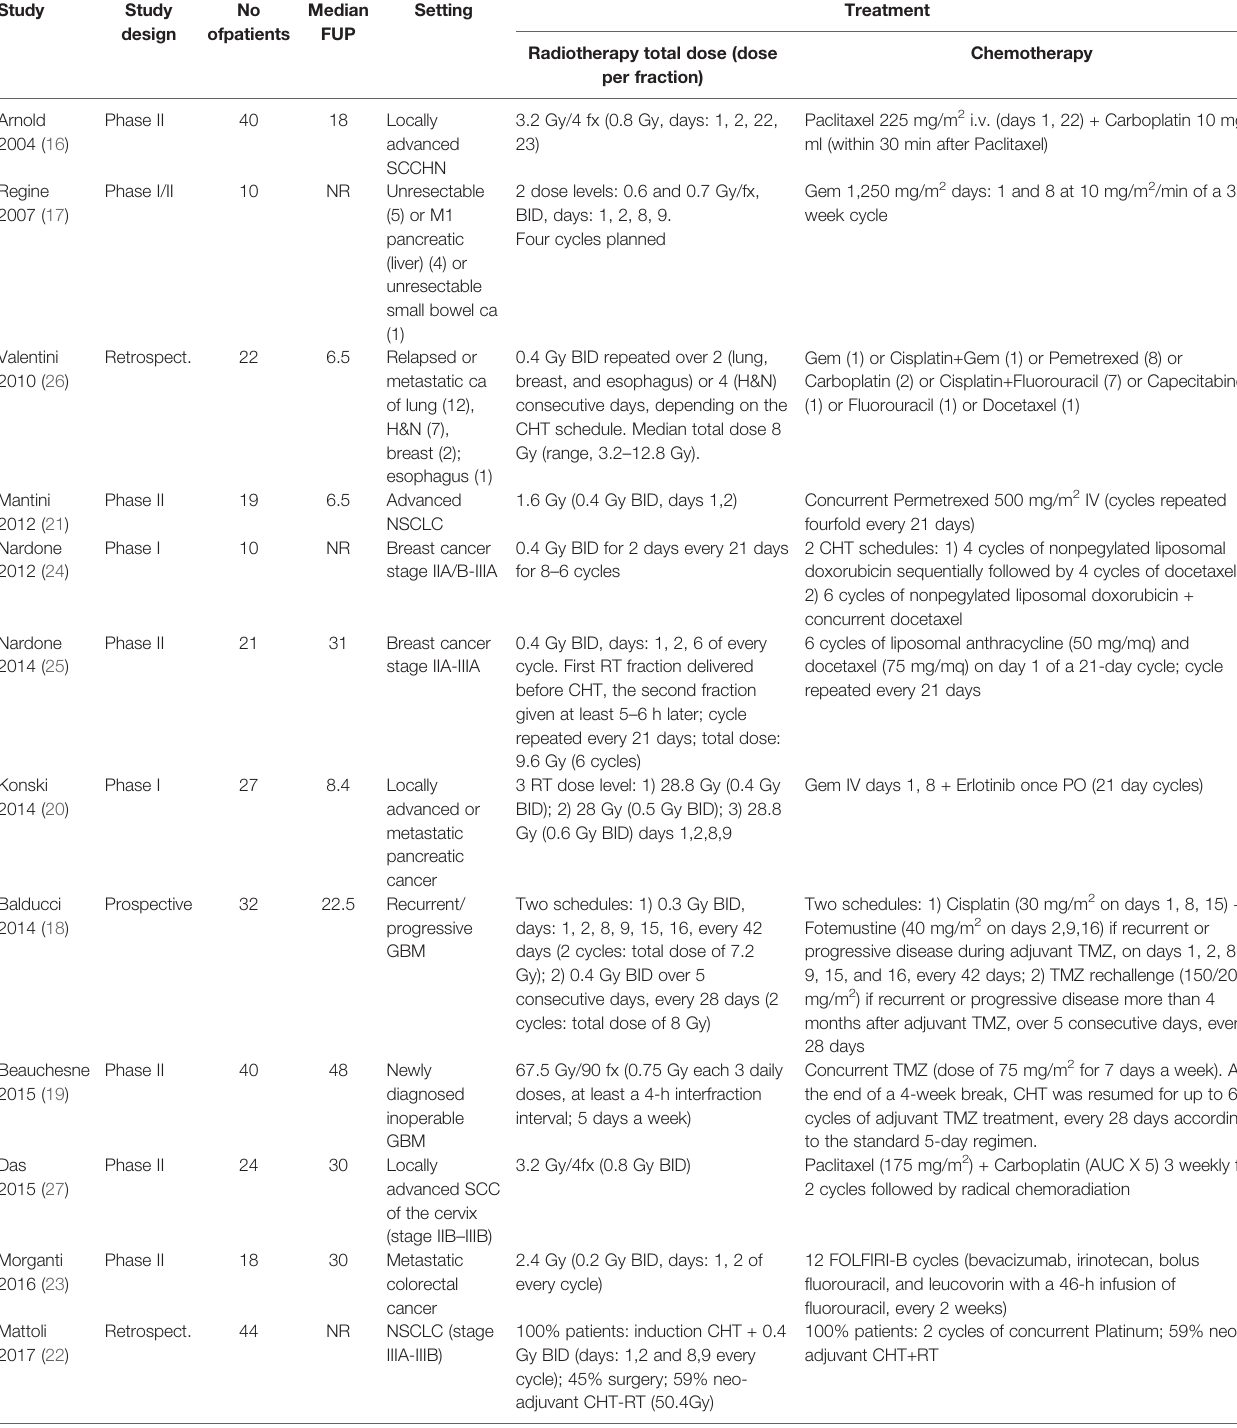
TABLE 1 | Studies